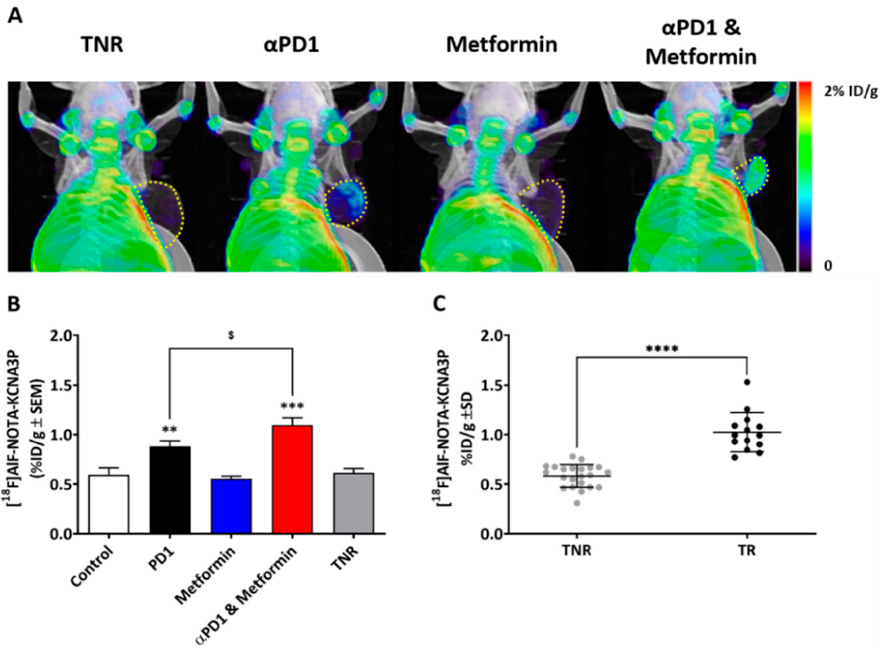
Figure 2. ( A ) Representative MIP images indicating tumour retention of [ 18 F]AlF-NOTA-KCNA3P across the treatment cohorts. Tumour borders are shown as yellow dotted lines. ( B ) Bar graph indicating tumour retention of [ 18 F]AlF-NOTA-KCNA3P in each treatment cohort (Control, α PD1, metformin, combined α PD1 + metformin and TNRs; n = 5–10 mice/group; ** p < 0.01, *** p < 0.001 compared to TNR, $ p < 0.05 compared to α PD1; data shown as the mean %ID/g ± S.E.M.). ( C ) Retention of [ 18 F]AlF-NOTA-KCNA3P in individual tumours from TR and TNRs (**** p < 0.0001). Table 1. Table displaying [ 18 F]AlF-NOTA-KCNA3P tumour retention in each treatment cohort (control, α PD1, metformin, combined α PD1 + metformin and TNRs). [ 18 F]AlF-NOTA-KCNA3P Tumour Retention Treatment Group (%ID/g ± SD) Control 0.596 ± 0.173 Treatment Responders (TR) α PD1 0.883 ± 0.120 ** Metformin 0.557 ± 0.082 PD1 + Metformin 1.098 ± 0.203 *** $ Treated Non-Responders (TNR) 0.617 ± 0.105